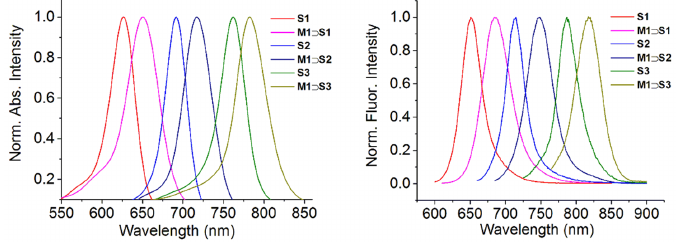
Figure 1. Absorption ( left ) and emission ( right ) maxima for separate solutions of S1 , S2 and S3 and their threaded complexes with M1 in CHCl 3 .